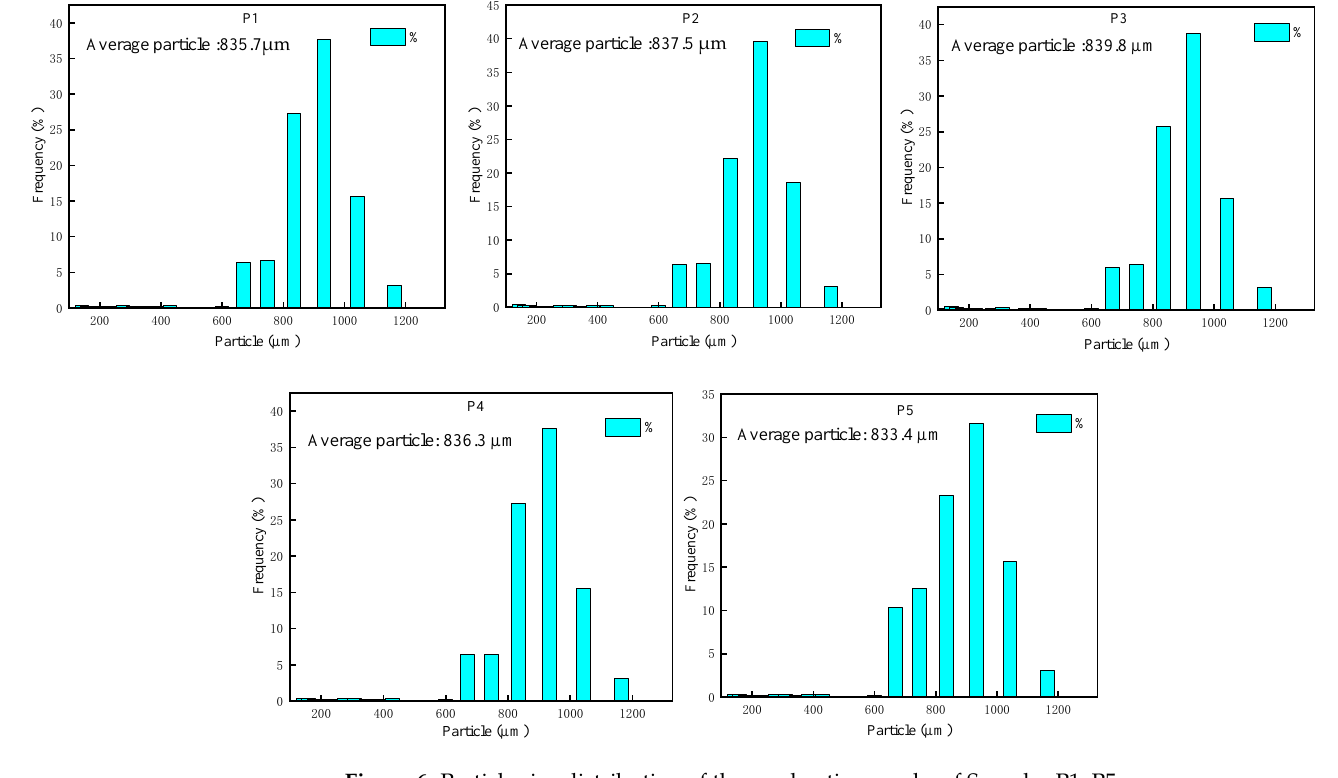
Figure 6. Particle size distribution of the combustion smoke of Samples P1–P5.